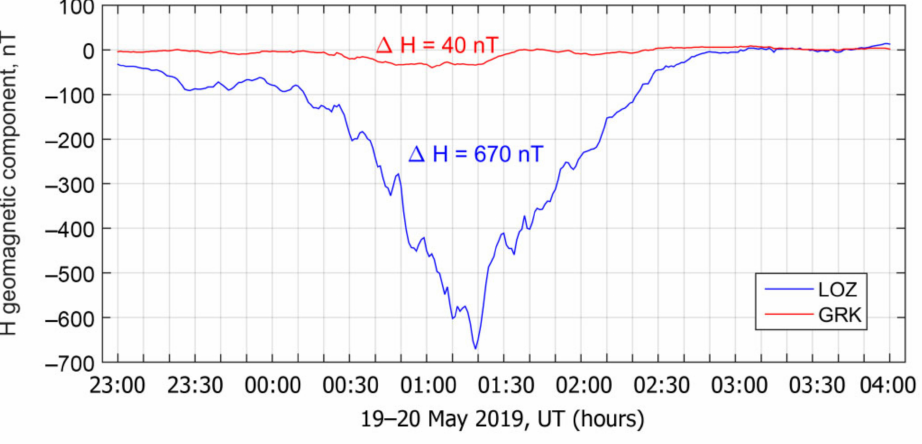
Figure 7. The geomagnetic field horizontal component (H) time course, measured at LOZ (blue line) and GRK (red line) from 23:00 UT on 19 May 2019 to 4:00 UT on 20 May 2019. The OS and VS comparison with model results is shown in Figure 6A; sporadic flat layer (type f, red circles in Figure 6) was observed during the entire interval (partly at